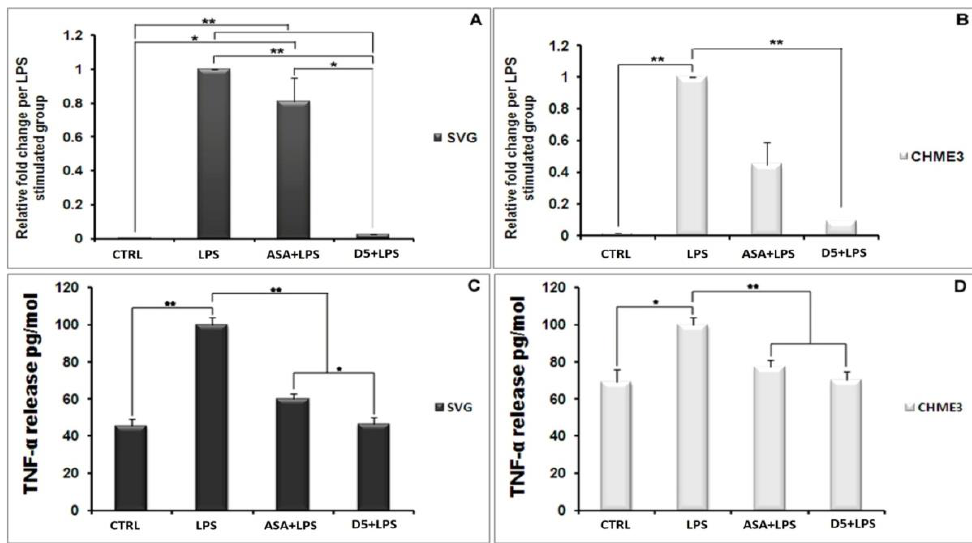
Figure 3. Inhibitory Effects of D5 on TNF- α mRNA and protein levels in LPS-Stimulated SVG astrocyte and CHME3 microglia cell lines. SVG astrocytic glial and CHME3 microglial cells were treated with D5 and ASA (0.71 µM and 52.73 µM, respectively) for 2 h, and then incubated with LPS (100ng/mL) for 24h. Total cellular mRNA was isolated from SVG ( A ) and CHME3 ( B ) cells and the optical density of individual TNF- α mRNA was normalized to the corresponding levels of GAPDH mRNA. Amounts of TNF- α released from SVG ( C ) and CHME ( D ) cells into the culture medium were measured using human TNF- α and IL - 1β ELISA kits based on the quantitative sandwich enzyme immunosorbent technique. Quantitative analyses were shown as % or fold increases in the control unstimulated group. Data are presented as the mean ± S.D. of four samples in one independent experiment. The data were replicated in three repeated independent experiments. One-way ANOVA followed by post hoc analysis was performed for the comparison of the mean values of the level of TNF- α mRNA and protein expressed in the D5-treated group and the rest of the groups. * p < 0.05; ** p < 0.01 probability.